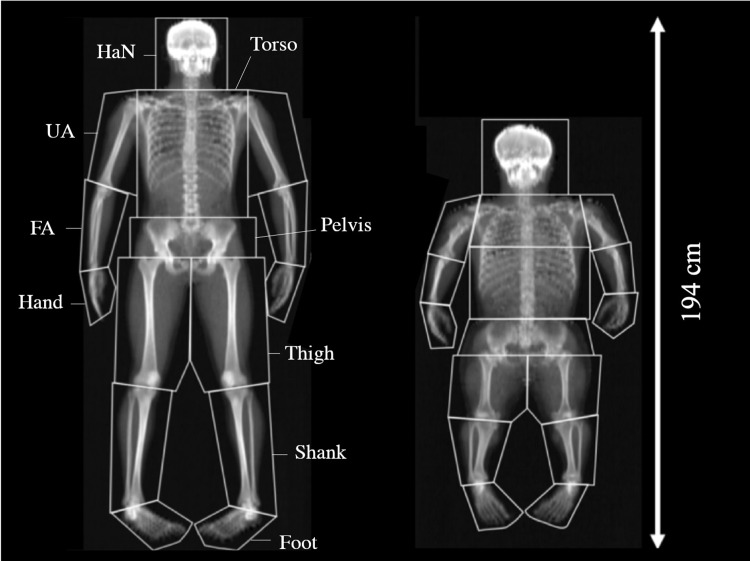
DEXA scans for (left) control and (right) achondroplasia.Segmental analysis and shown as head and neck (HaN), torso and pelvis for axial segments and upper arm (UA), forearm (FA), hand, thigh, shank and foot for the appendicular segments. Note: the thorax of achondroplasia was divided into two segments and then summed after analysis to ensure the correct mass was encompassed in the region.